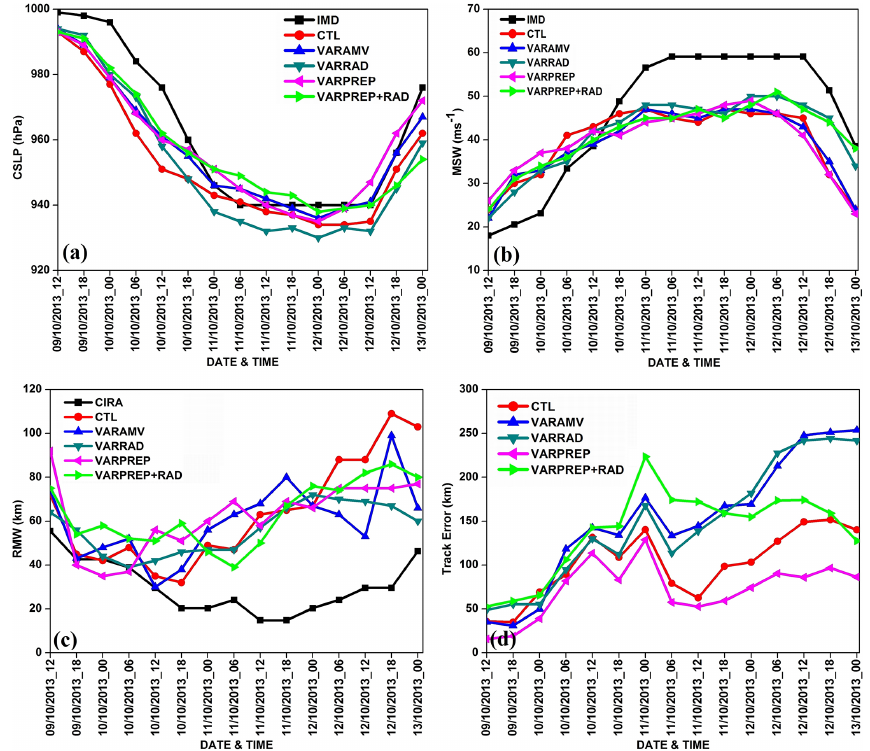
Figure 9. Time variation of (a) CSLP (hPa), (b) MSW (ms − 1 ), (c) RMW (km) and (d) vector track errors (km) of Phailin in CTL and 3D-Var experiments (time in UTC). The CSLP and MSW of the operational IMD forecasts and RMW of CIRA data are also